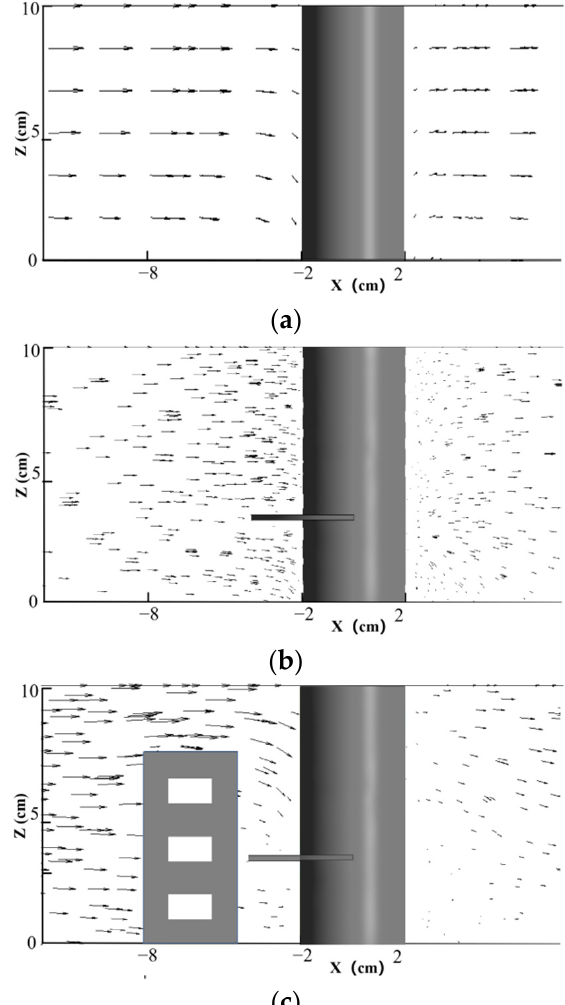
Figure 14. Velocity vectors at Y = 0. ( a ) Single pier; ( b ) Pier with ring-wing plate; ( c ) Pier with combined device.